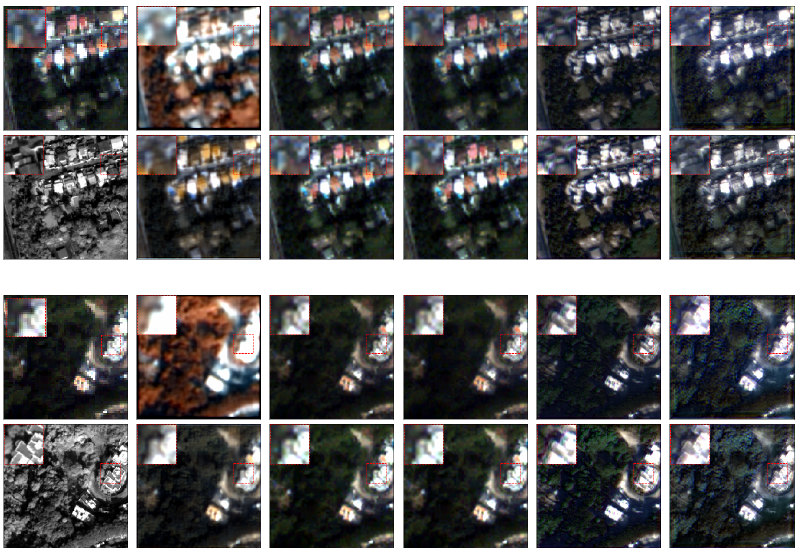
Figure 6. Fused results of two randomly selected samples from the QuickBird test set. From left to right are the original LRMS/PAN images, results of PNN, RSIFNN, PanNet, PSGAN, and PercepPan with the ESRGAN generator,